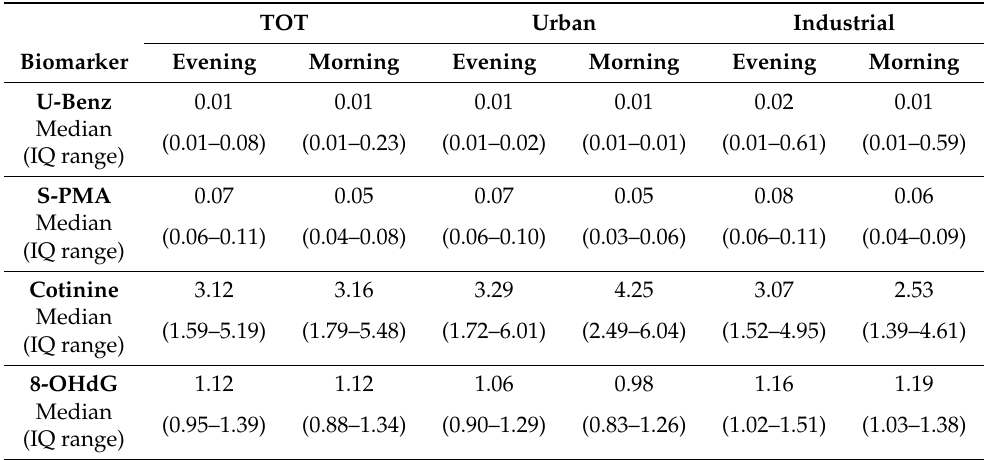
Table 5. Median and IQ range of biomarkers of exposure to benzene (U-Benz expressed in µ g/L and S-PMA expressed in µ g/g creat), cigarette smoke (botinine, ng/gcreat), and oxidative damage to DNA (8-OHdG, µ mol/mol